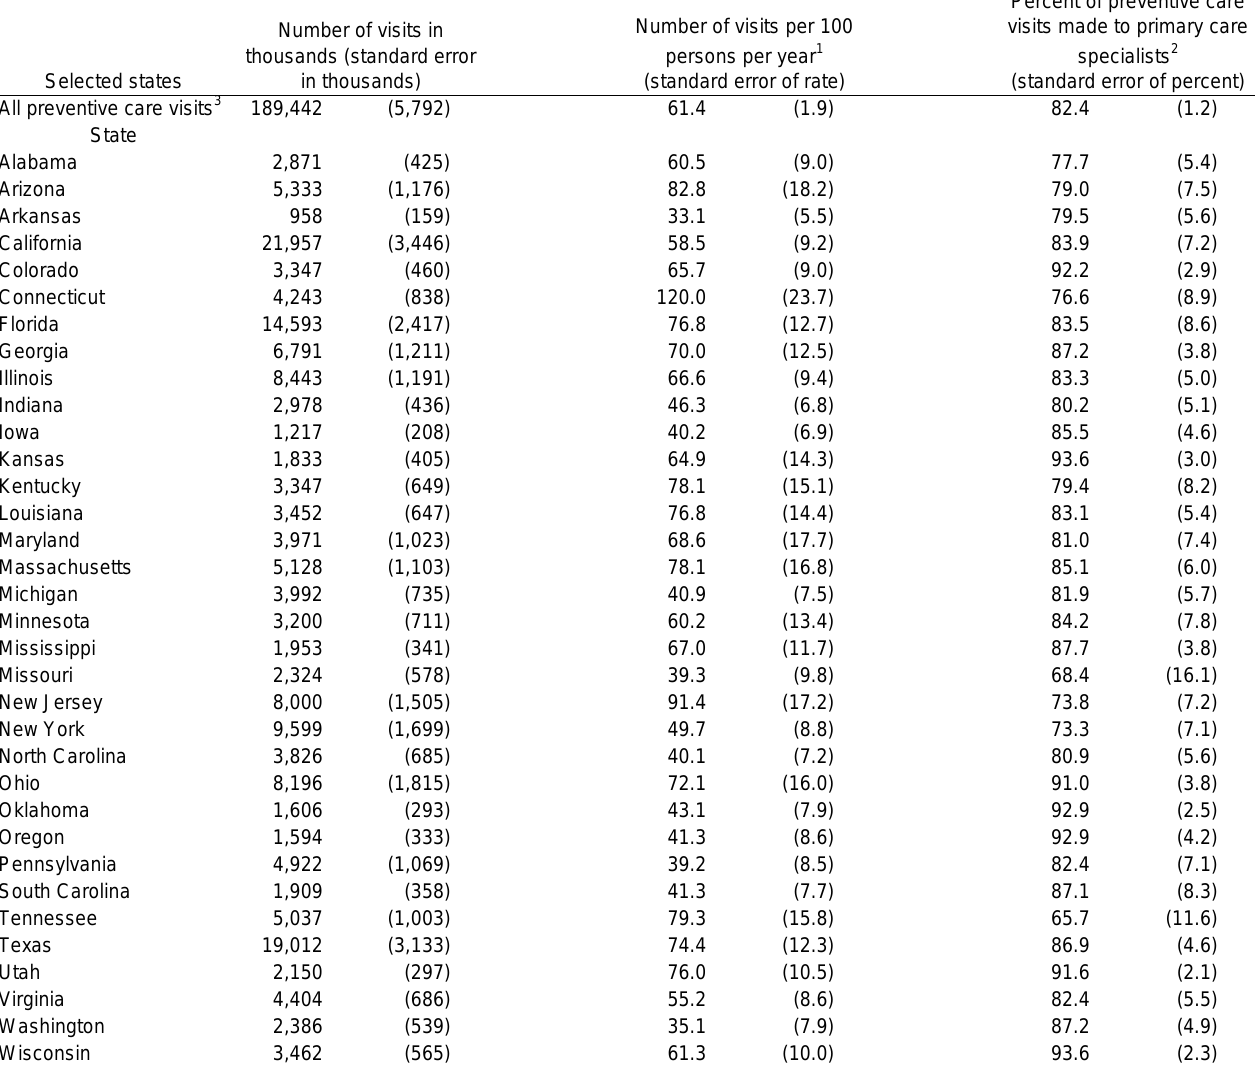
Table 14. Preventive care visits made to primary care specialists, by selected states: United States,